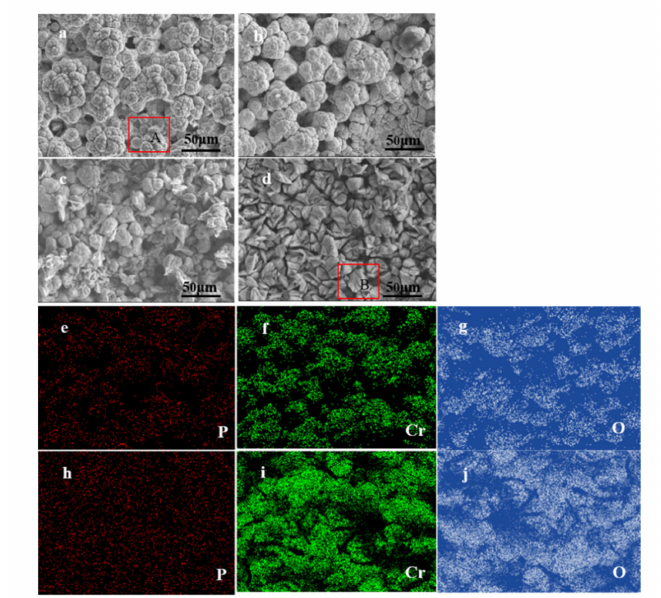
Figure 14. SEM and EDS images of the NiCrP alloy coatings before and after corrosion: ( a ) as-deposited coating, coatings immersed for ( b ) 12, ( c ) 24, and ( d ) 72 h, ( e – g ) P, Cr and O surface distribution in the as-deposited coating, and ( h – j ) P, Cr and O surface distribution after 72-h